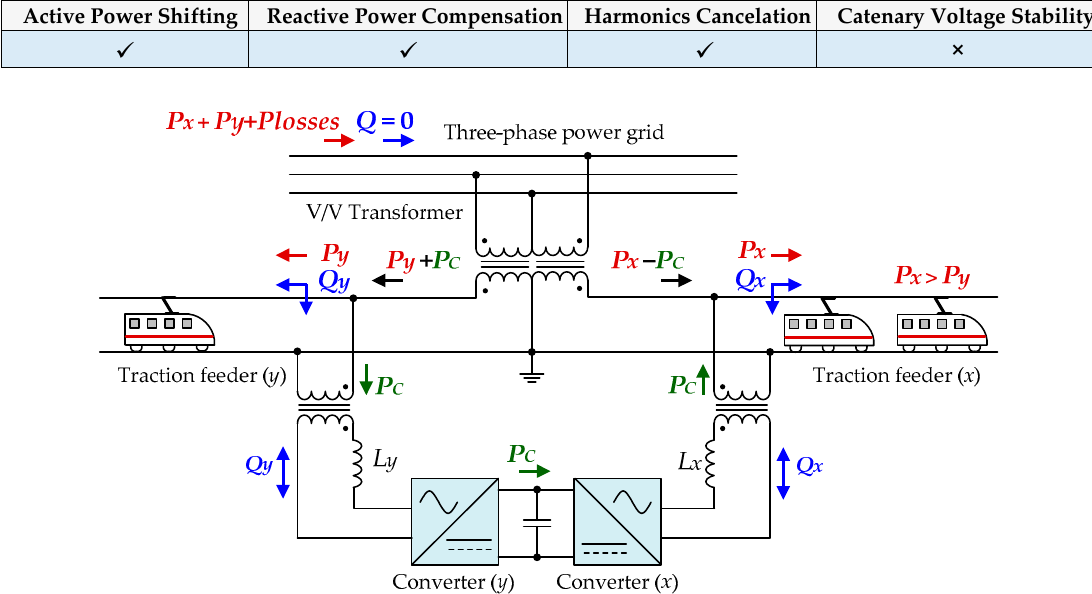
Figure 6. Operation principle of the RPC system (based on [44]).